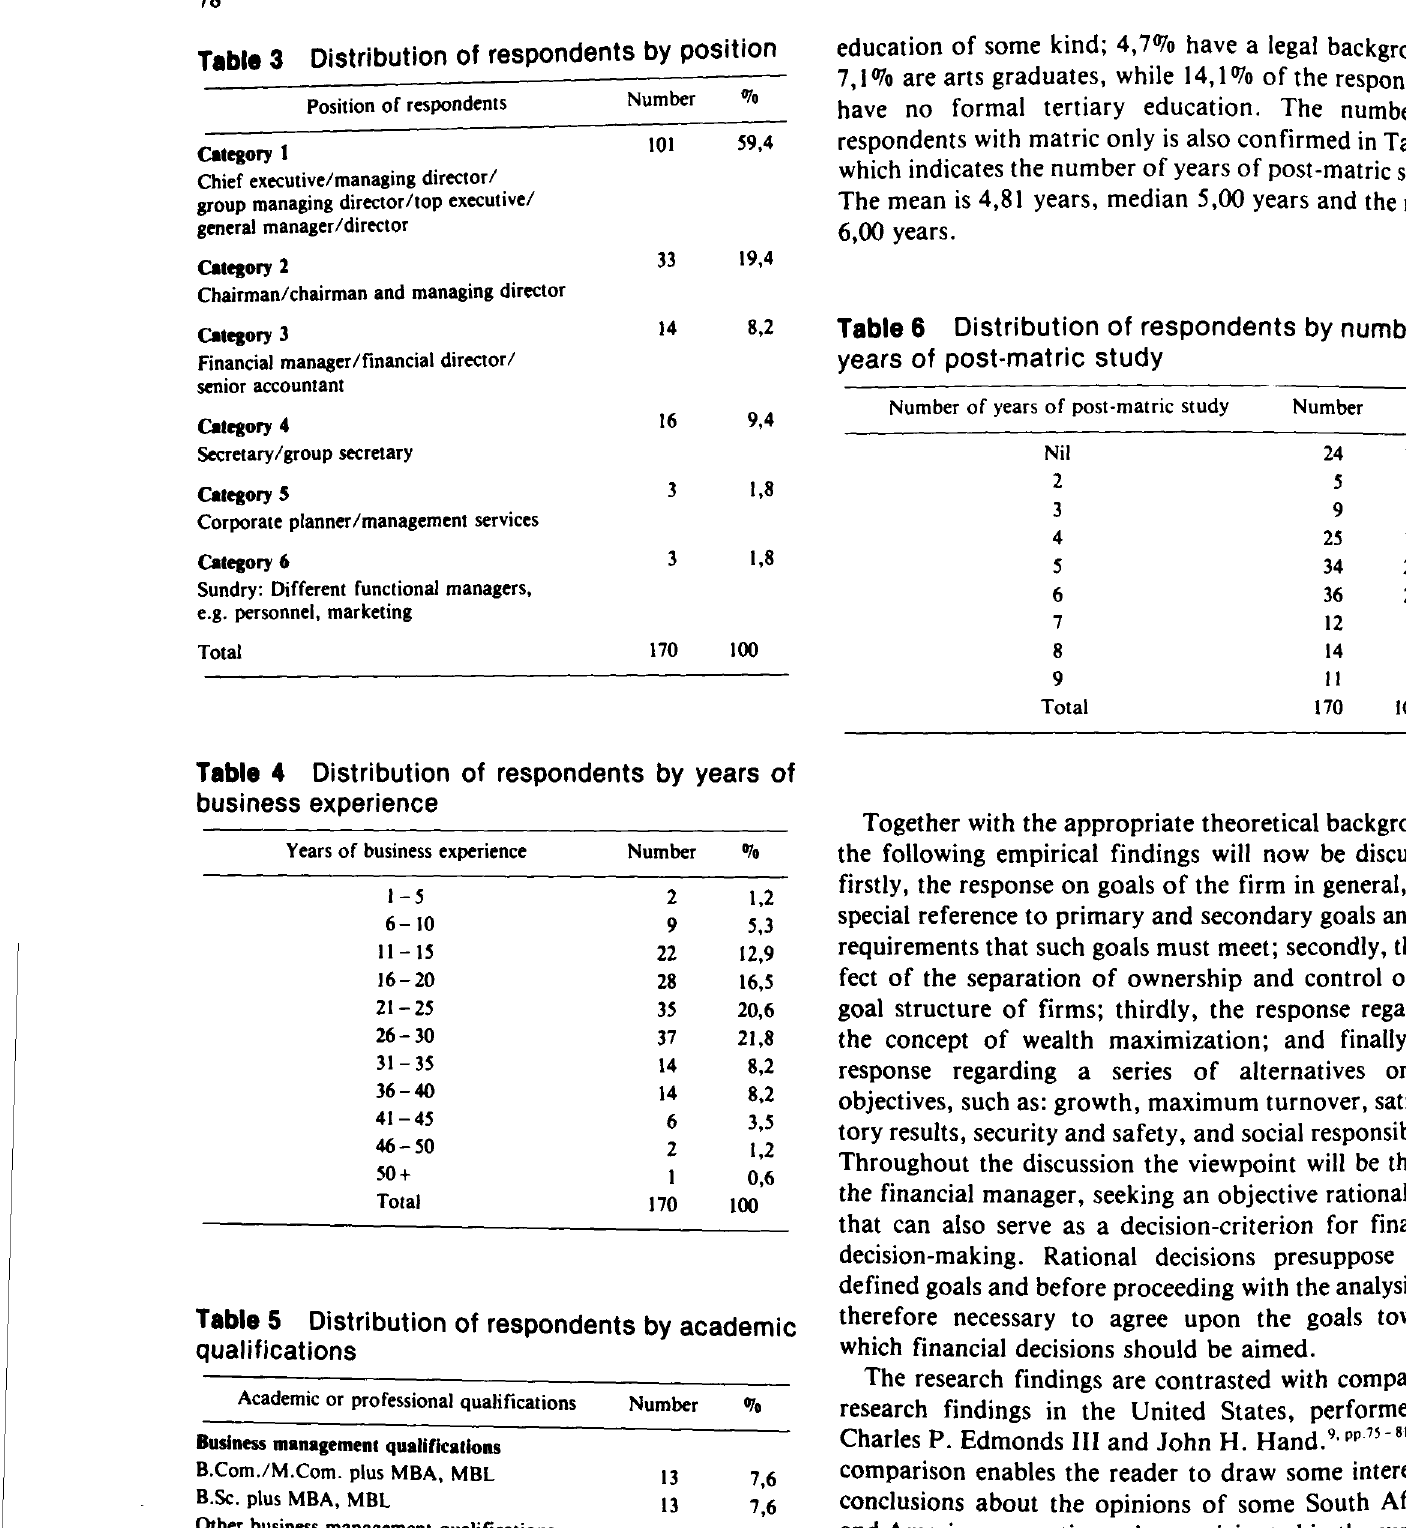
Distribution of respondents by